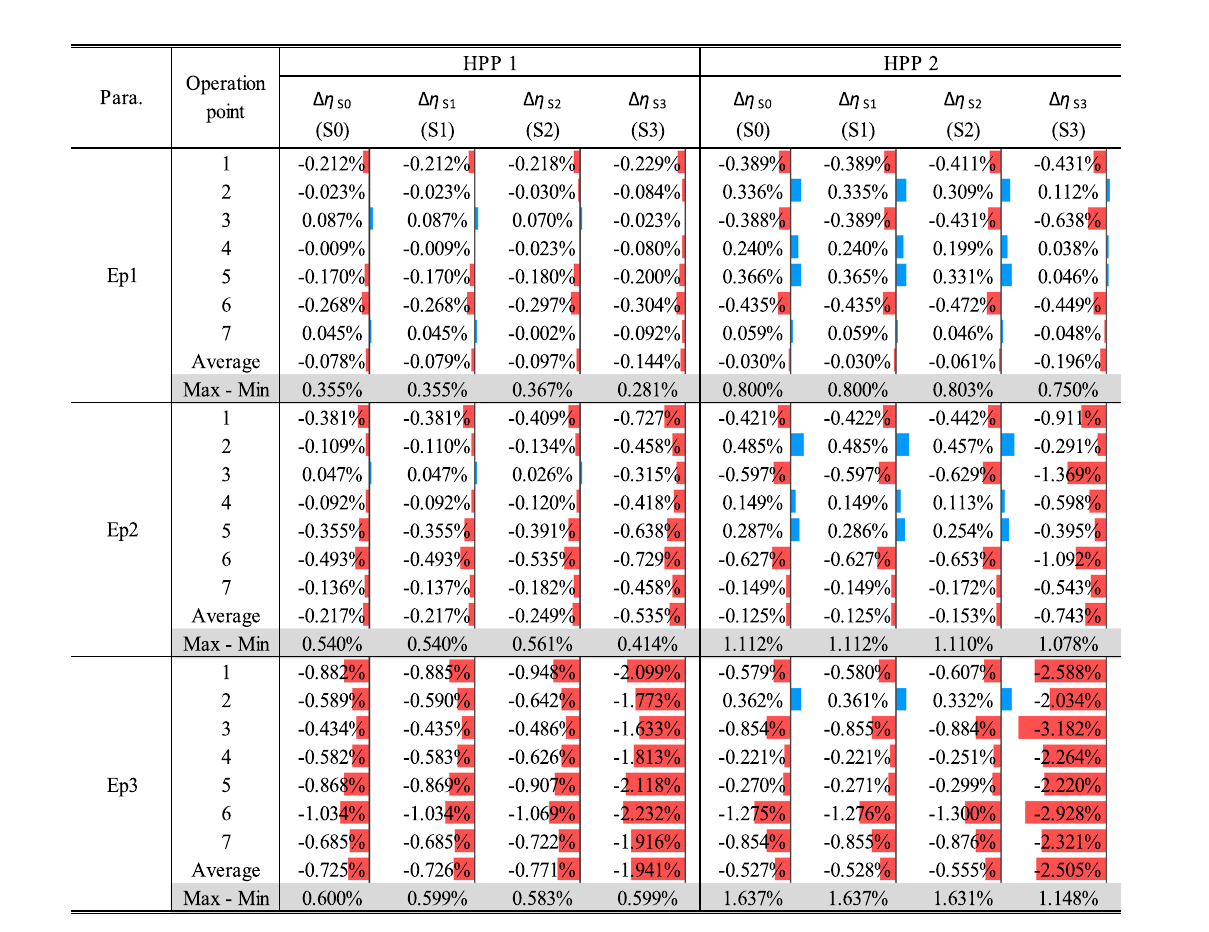
The seven operating points of each HPP are shown in Supplementary Fig. 16. Negative values mean ef fi ciency loss. The bar in each cell is a graphical representation of the value, and the negative and positive values are highlighted by red and blue, respectively. The average values of seven points are selected as the representative results listed in Table 1. The value of “ Max – Min ” is the difference between the maximum and minimum of the ef fi ciency changes of seven points.